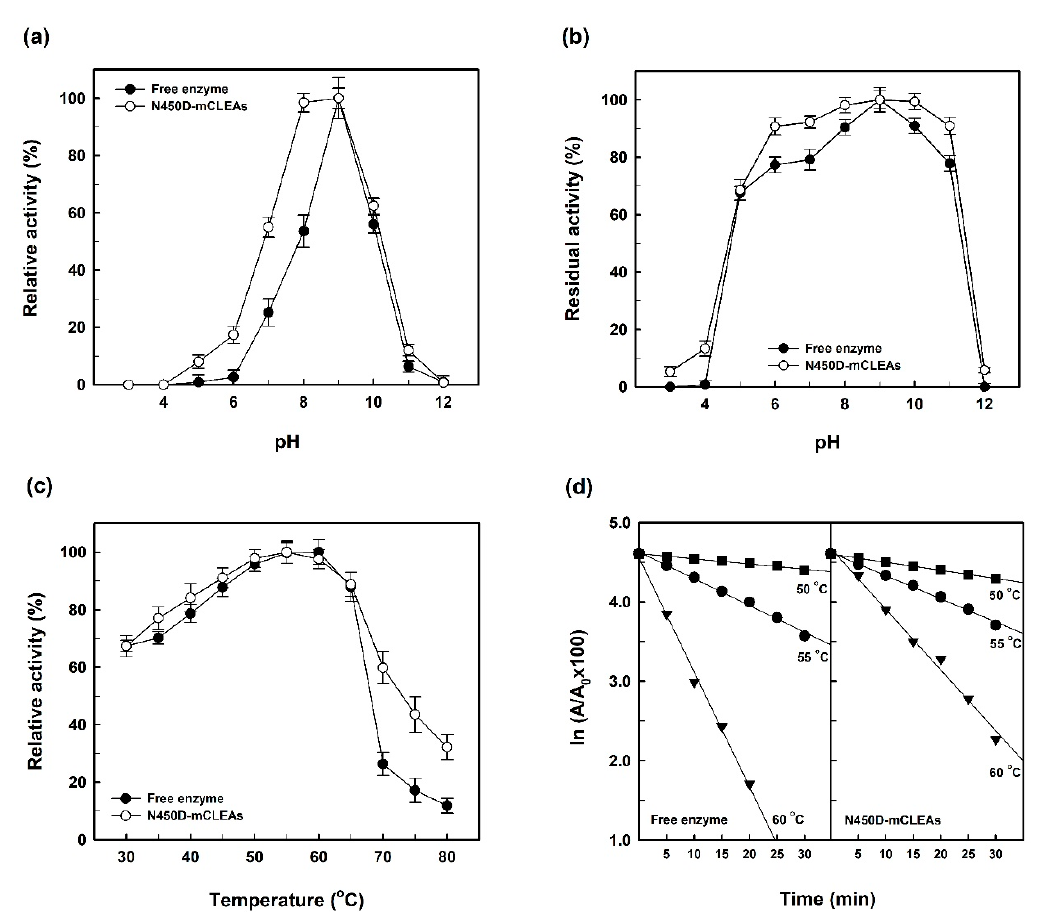
Figure 6. Effects of pH and temperature on the catalytic activity ( a , c ) and stability ( b , d ) of N450D and N450D-mCLEAS.